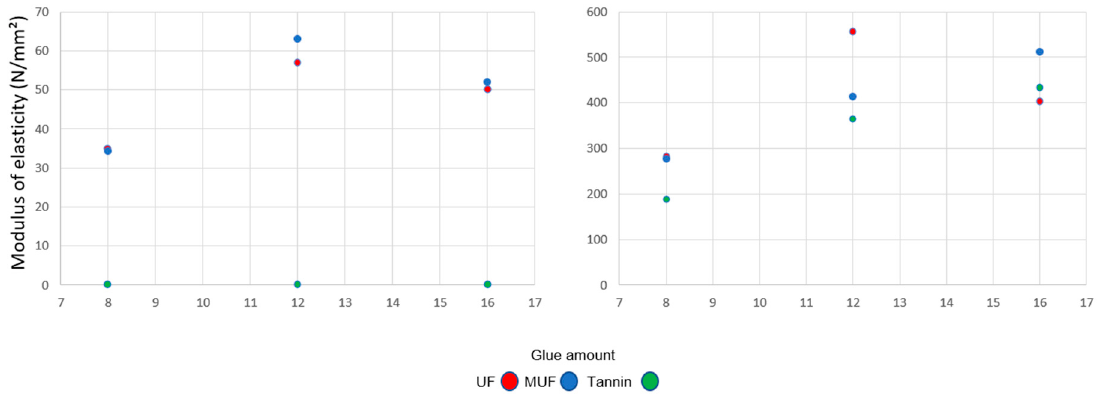
Figure 4. Modulus of elasticity at three levels of glue amount for 300 kg/m 3 ( left ) and 500 kg/m 3 ( right ).